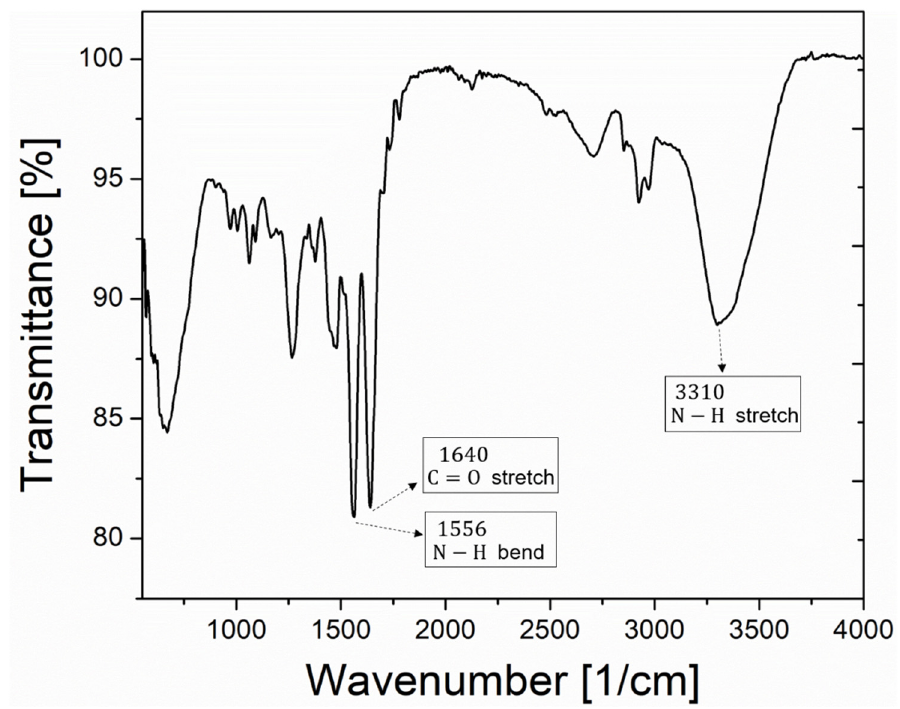
Figure 2. Infrared absorption spectrum for the QDs-immobilized bimetallic film (QDs-2 nm Au-50 nm Ag) on a glass substrate. A number of absorption peaks as indicated by arrows supports the presence of amine-carboxylic bonds [25–28] required for QD immobilization.